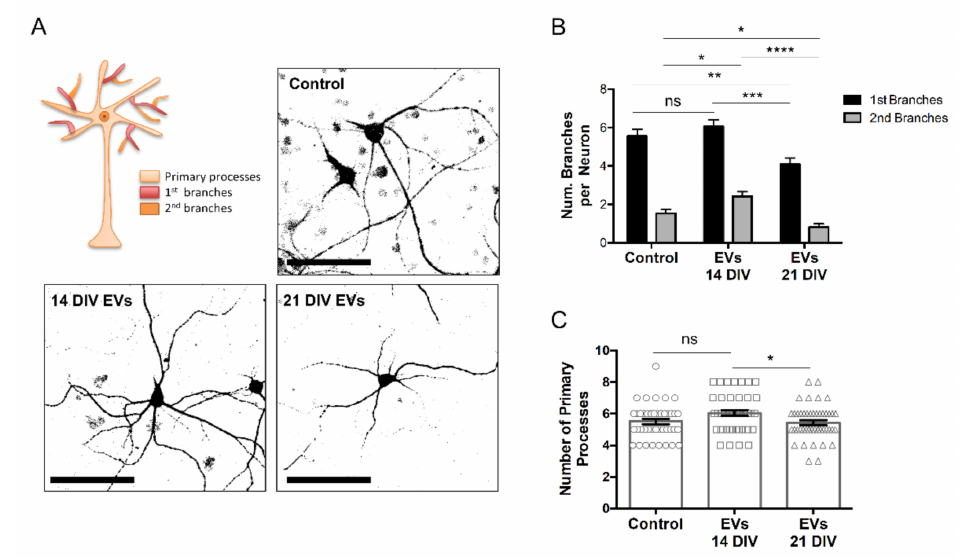
Figure 5. Effect of 14 and 21 DIV isolated EVs on neuronal branching. ( A ) Representative confo- cal images of neuronal processes, detected with an antibody against the dendritic marker MAP2, of 14 DIV neural culture untreated (control) or treated for 24 h with EVs isolated from the me- dia of 14 DIV (EVs 14 DIV) or 21 DIV (EVs 21 DIV) neural cultures. A scheme highlighting the primary processes, primary branches, and secondary branches of neurons is shown on the left upper quadrant of this panel. 14 DIV neural cultures untreated (control) or treated for 24 h with EVs 14 DIV or EVs 21 DIV were analyzed for the number of primary and secondary branches per neuron (bar = 100 µ m) ( B , C ) number of primary processes. All graphs show mean values ± SEM. Statistical significance was analyzed by one-way ANOVA. Tuckey’s Multiple Comparison Test was used for post hoc analysis (ns = non-significant, * p < 0.05, ** p < 0.01, *** p < 0.001, **** p < 0.0001; n = 3 independent